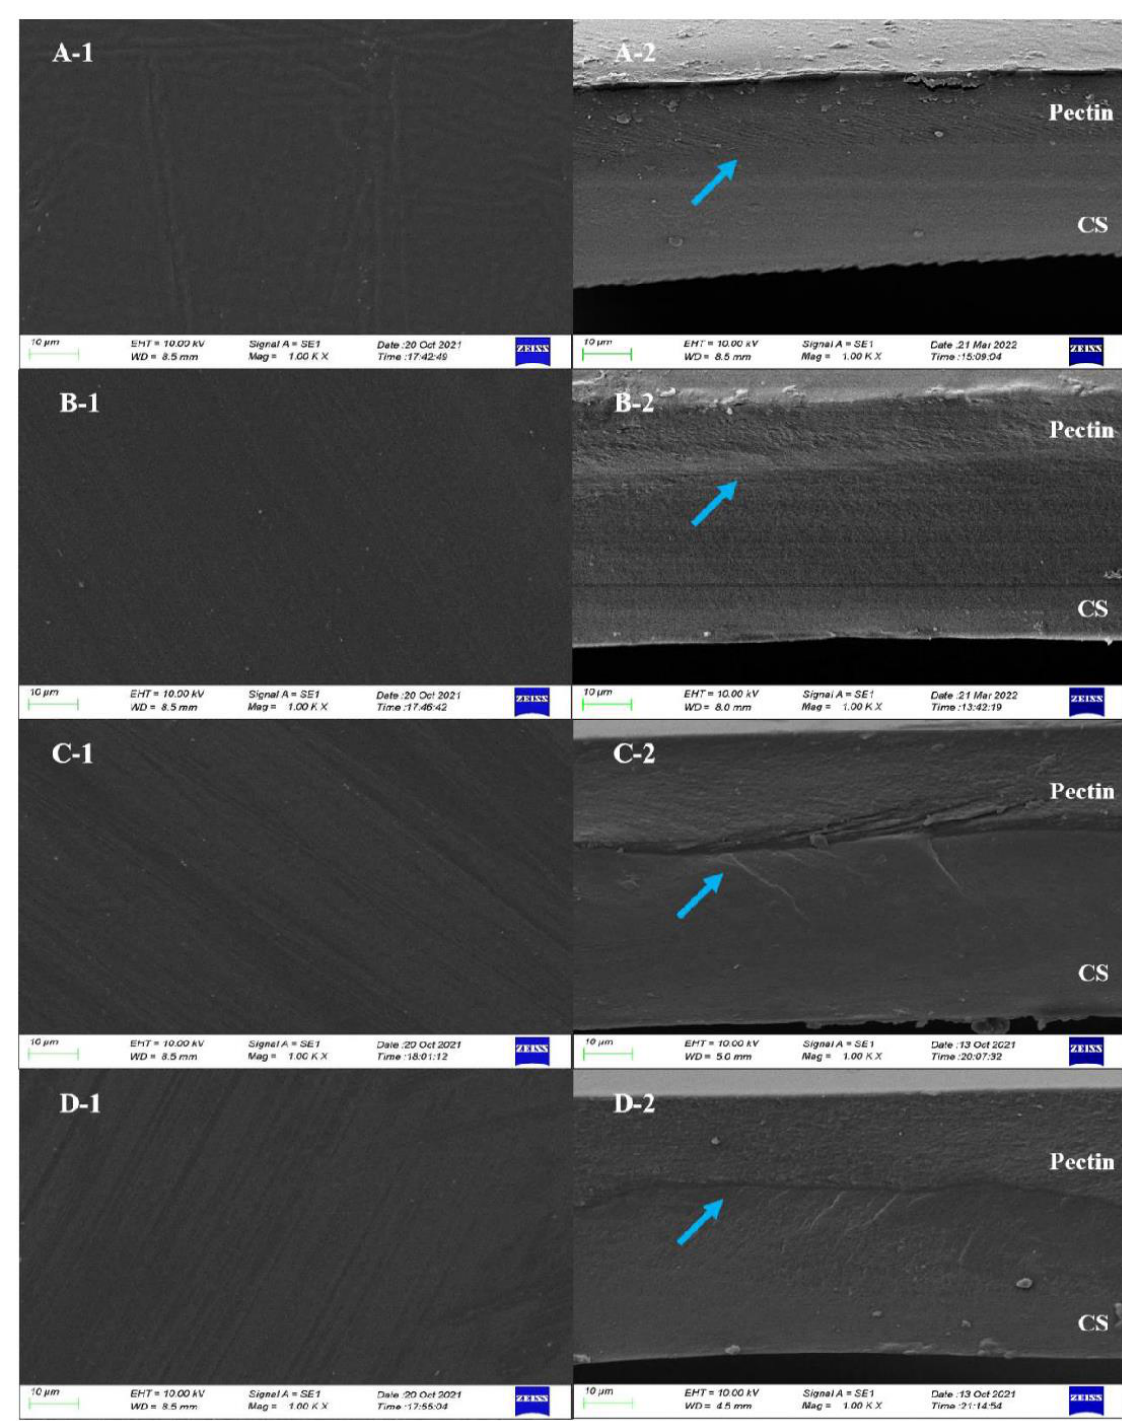
Figure 3. SEM micrographs of surface (1) and cross-section (2) of CS-pectin bilayer films (( A ): CS- L200, ( B ): CS-L201Y, ( C ): CS-H183, ( D ): CS-H182). The boundary of bilayer was pointed by the CS-L200, ( B1,B2 ): CS-L201Y, ( C1,C2 ): CS-H183, ( D1,D2 ): CS-H182). The boundary of bilayer was blue arrow. pointed by the blue